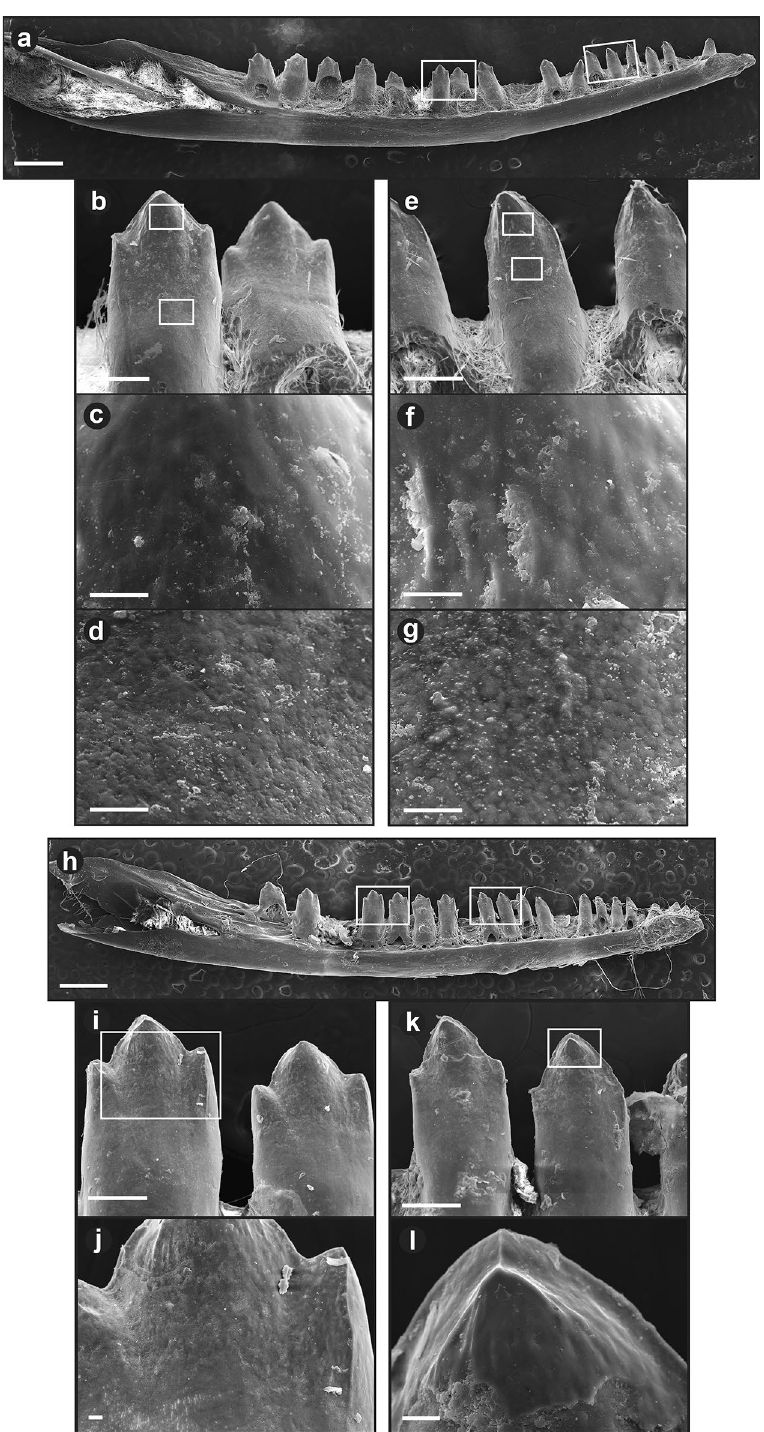
Figure 3. Corrosion damage to teeth of Green Anoles ( Anolis carolinensis ) ingested by Barn Owls ( Tyto alba ): ( a – g ) whole lower jaw, whole teeth and close-ups of crown and shaft of specimen #H4, where corrosion is confined to the shaft; ( h – l ) whole lower jaw, whole teeth and close-ups of crown and shaft of specimen #F2, where corrosion has proceeded onto the crown, leaving on the front teeth a discrete step. Scale bars: ( a ) and ( h ), 1 mm; ( b , e , i ) and ( k ), 200 µm; ( c – d , f – g , j ), and ( l ), 20